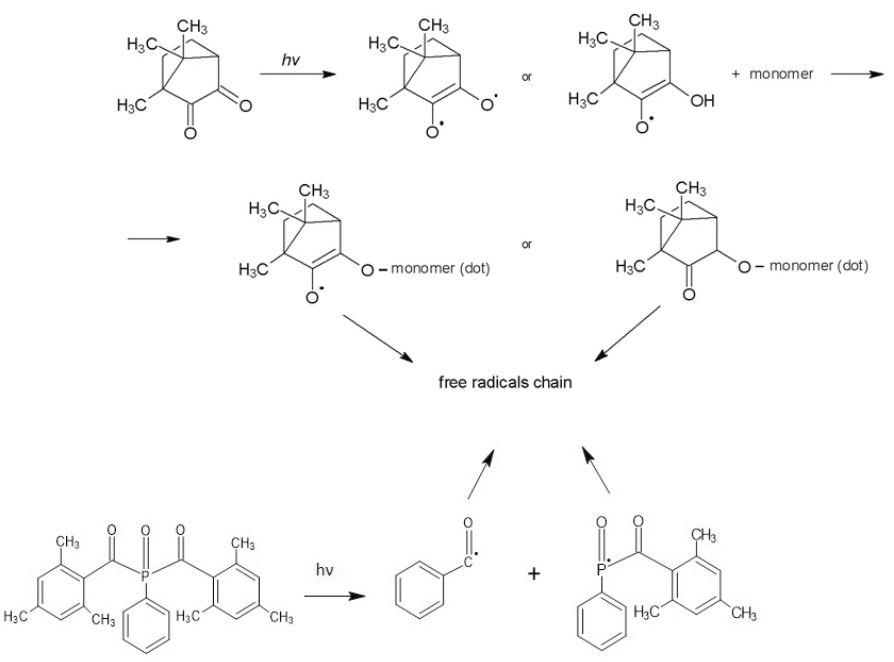
Figure 6. Scheme of the hypothesized mechanism concerning the formation of oxygen-centered free radicals on BD molecule under Vis-irradiation and phosphorous- and carbon-centered free radicals on the BAPO